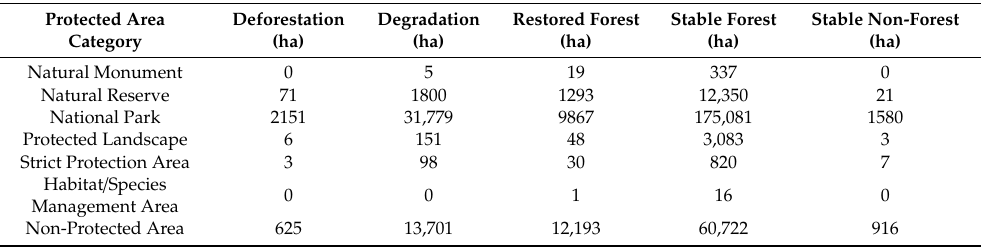
Table 5. Dynamics of land cover change associated with the di ff erent classes of protected areas in the Dominican